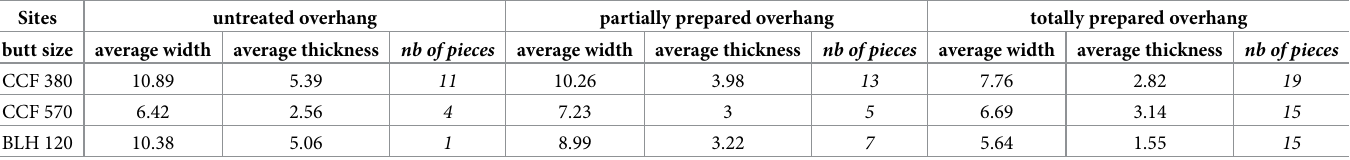
Table 5. Average butt width and thickness by type of overhang preparation. Sites untreated